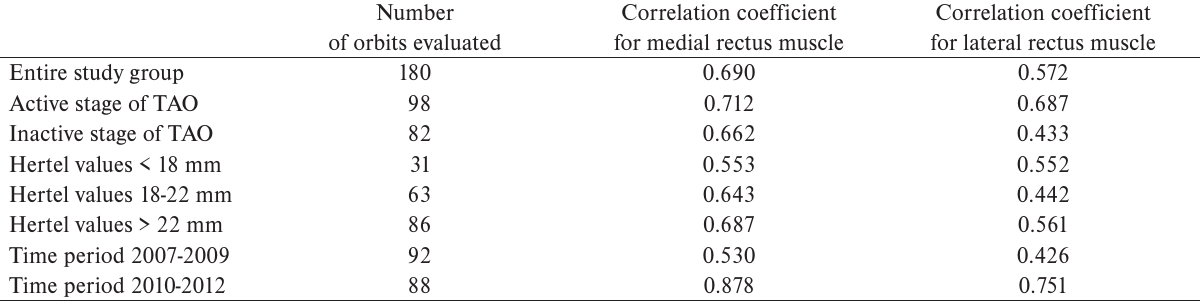
Table 3. Spearman correlation coefficients between maximal horizontal muscle diameters obtained by ultrasound and by MRI. Number Correlation coefficient Correlation coefficient of orbits evaluated for medial rectus muscle for lateral rectus